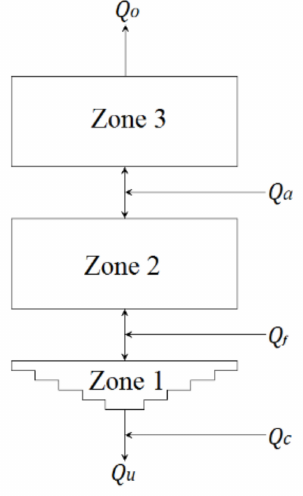
Figure 3. Zones of hydraulic